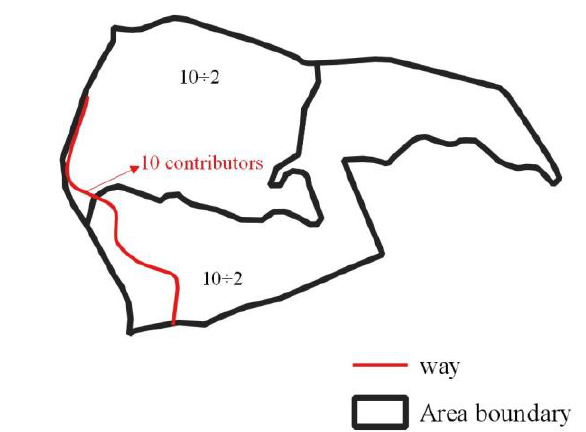
Figure 2. Solution for ambiguity relationship